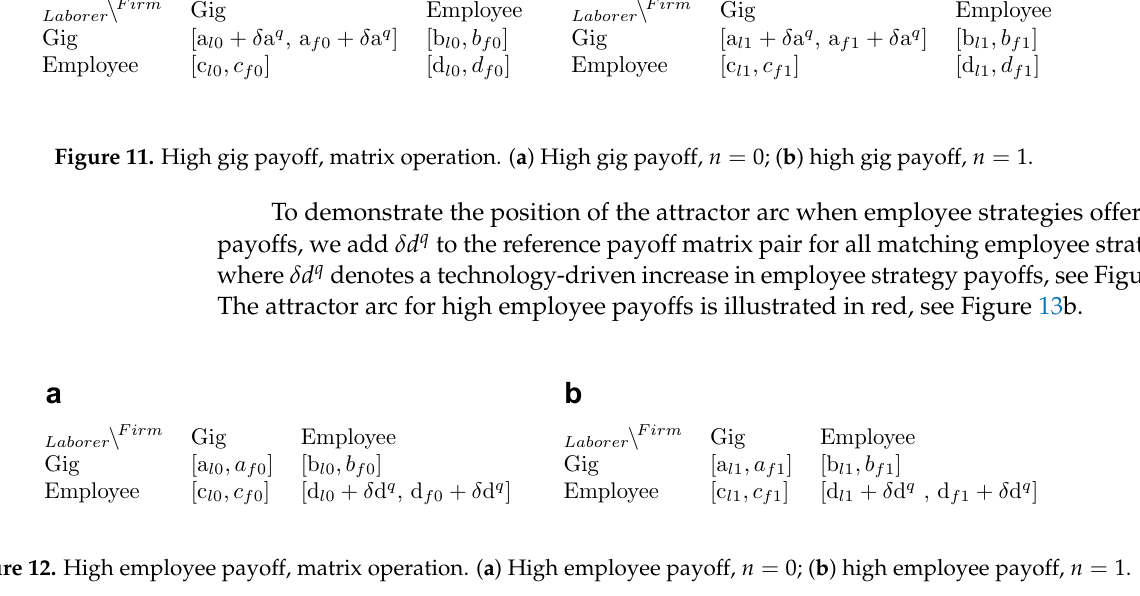
Figure 3: Lenient Policy, Matrix Operation